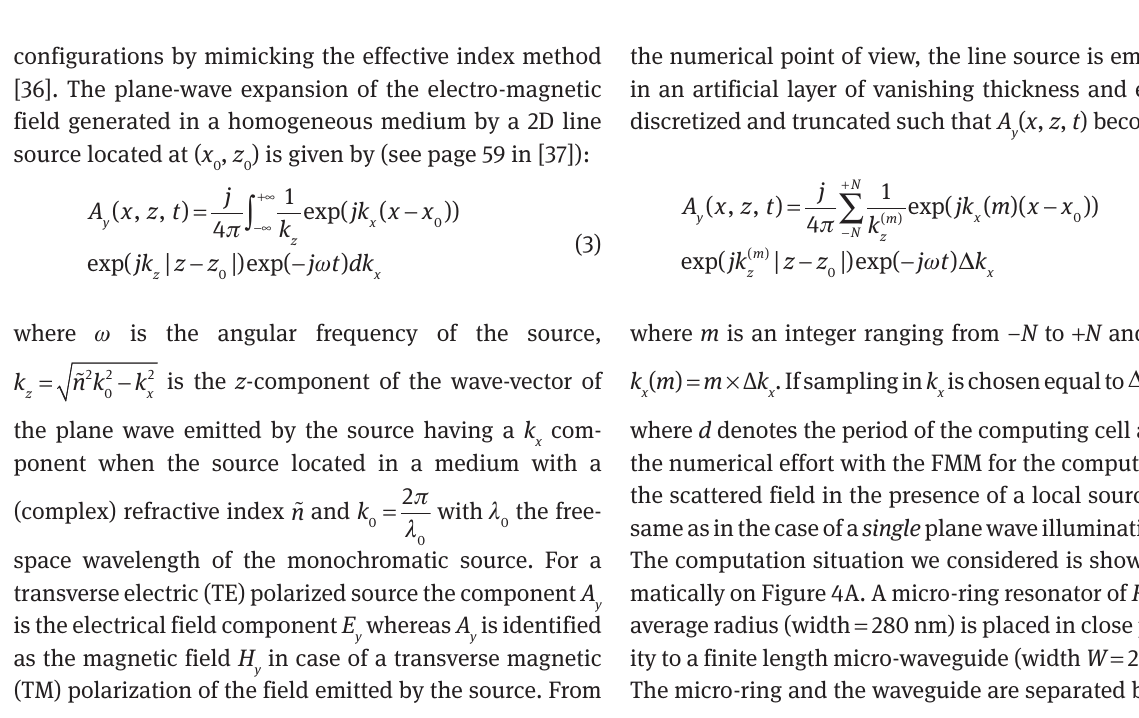
Figure 4: (A) Schematic view of the computational situation for bus-waveguide and TWR excitation configurations. (B) [resp. (C)] Electric field intensity distribution at 670.37 nm for a 8 μ m radius resonator coupled to a 280 nm wide waveguide. The separation gap is g = 130 nm. On both images, the yellow arrow shows the location of the local